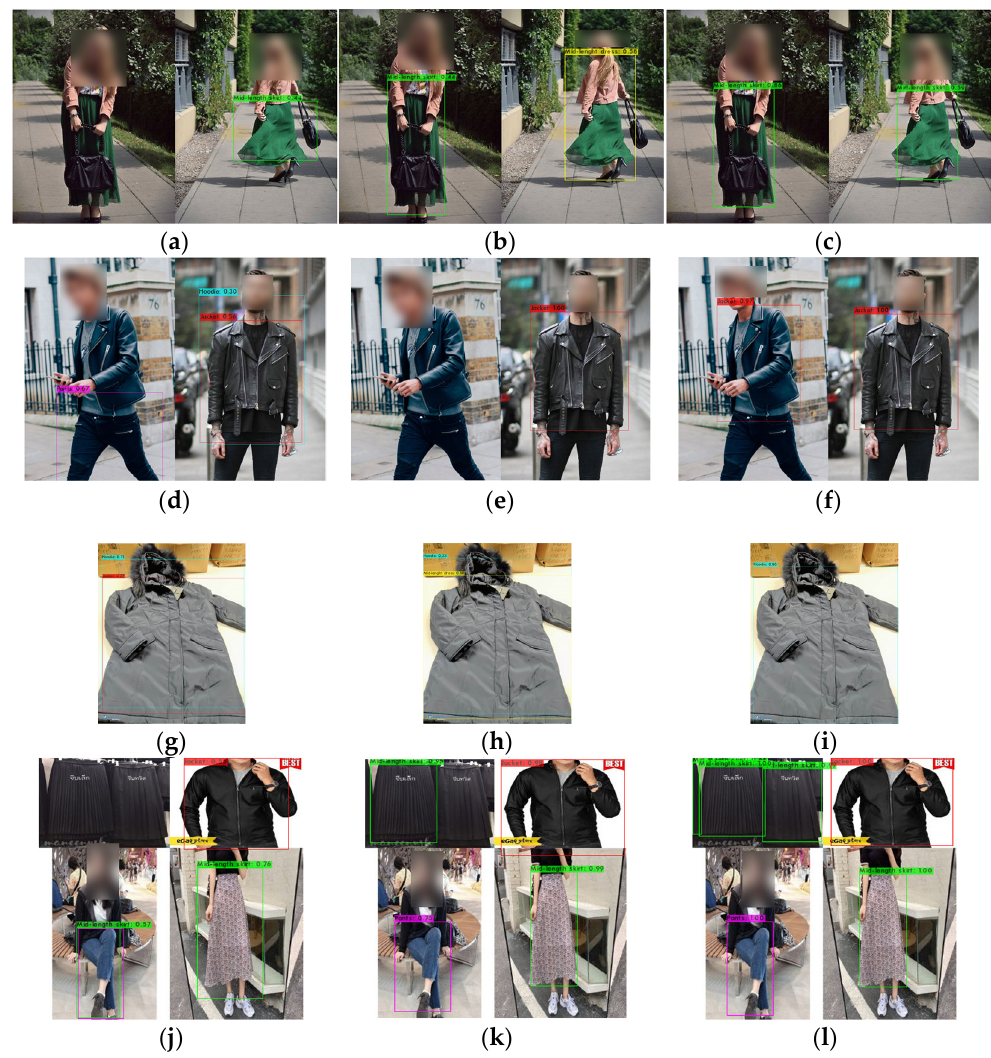
Figure 16. Detection results of YOLOv3, YOLOv4, and our proposed FC-YOLOv4. ( a , d , g , j ) YOLOv3 Detection Results; ( b , e , h , k ) YOLOv4 Detection Results; ( c , f , i , l ) FC-YOLOv4 Detection Results.